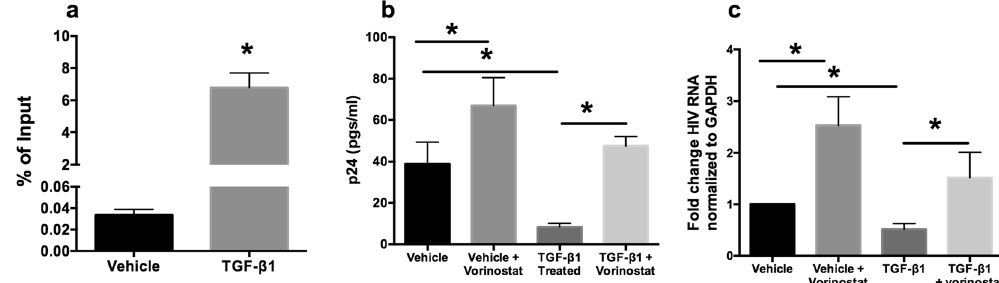
Figure 4. TGF- β 1 mediates HIV suppression via BLIMP-1 and histone deacetylases. NHBE ALI cultures were treated with TGF- β 1 or vehicle and infected similar to that in Fig. 1a. Chromatin was isolated on Day 3 and BLIMP-1 mobilization to HIV LTR was determined using CHIP. TGF- β 1 increases mobilization of BLIMP-1 to HIV LTR ( a ). n = NHBE ALI cultures from 4 different lungs; * significant (p < 0.05). Another set was TGF- β 1 treated and infected identically, On day 6 the HDAC inhibitor vorinostat (1 μ M) was added. On day 8 culture supernatants were collected and analyzed for HIV p24 ( b ). Total RNA was isolated and analyzed for HIV LTR using qRT-PCR ( c ). TGF- β 1 mediated HIV transcriptional suppression can be restored by HDACi suggesting a role of histone deacetylases in TGF- β 1 mediated HIV latency. n = NHBE ALI cultures from 5 different lungs; * significant (p < 0.05).